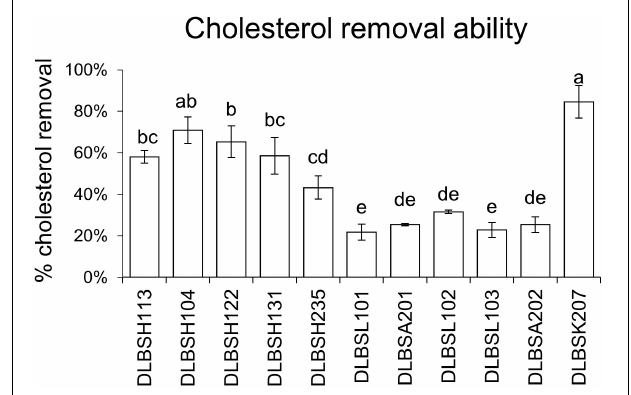
FIGURE 1 | Cholesterol removal ability of DLBS’ probiotic isolates collection. Cholesterol removal ability from 11 different isolates was measured after incubation at 37 ◦ C for 24 h in MRS broth media + 0.3% ox gall and cholesterol (100 mg/L). The result is expressed as mean ± SD of at least three independent experiments. Different letters (a–e) represent significant differences ( p < 0.05) for the comparison of all groups by one-way